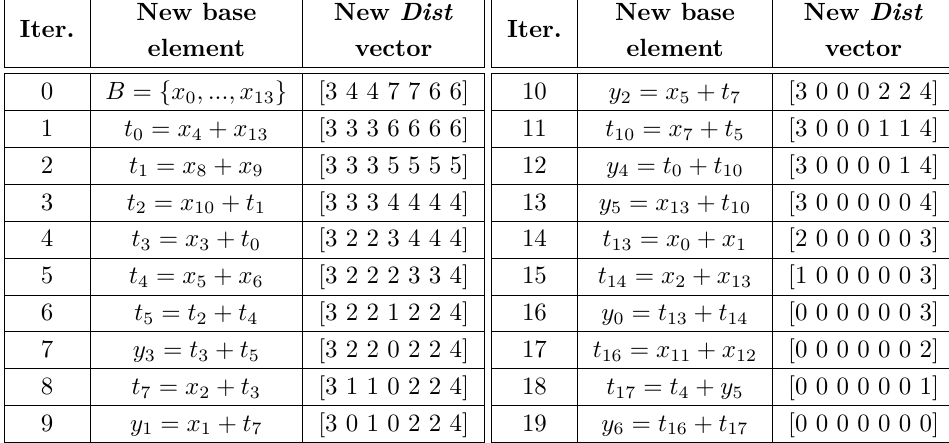
Table 2: Computation sequence when applying BP algorithm to matrix M . B refers to the initialized base elements, x i refers to the input signals ∀ i ∈ { 0 , ..., 13 } , y j refers to the targets ∀ j ∈ { 0 , ..., 6 } and t k refers to the temporary intermediate gates ∀ k ∈ N